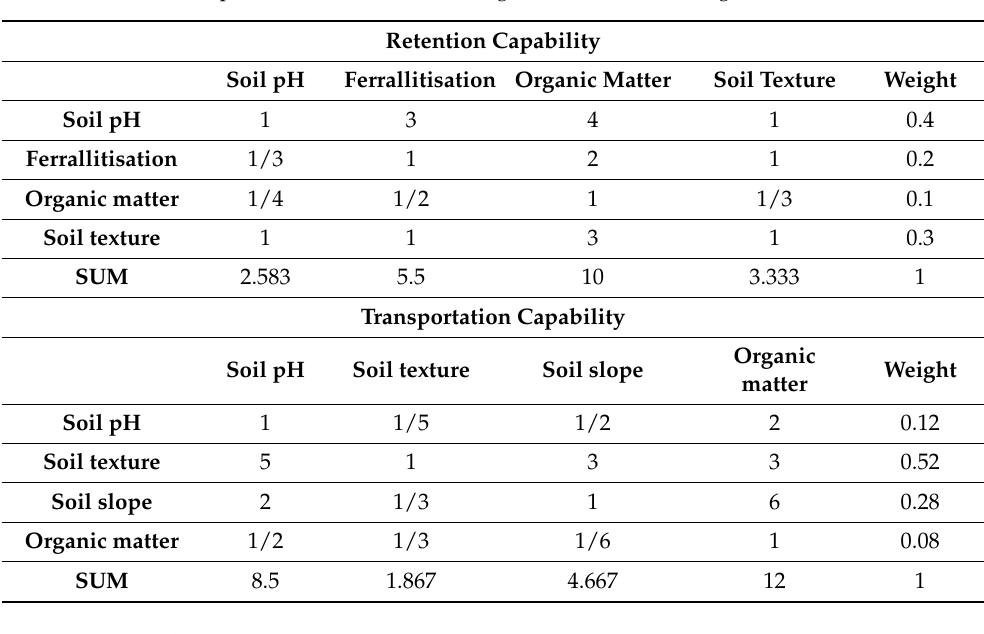
Table 3. Pairwise comparison matrix of influencing factors and their